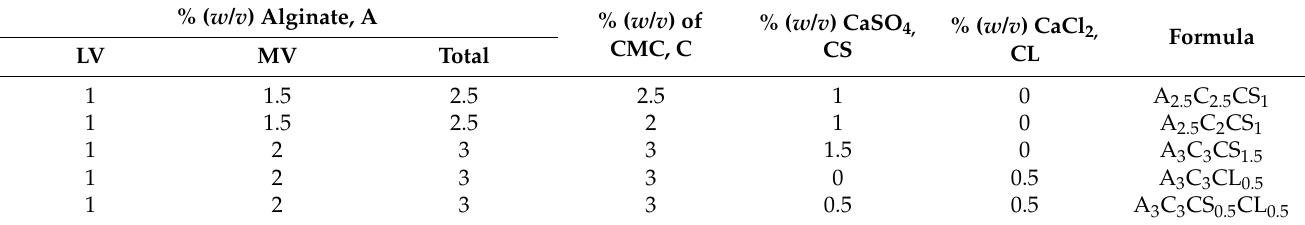
Table 1. Formulated hybrid hydrogels with weight percentages of various components.